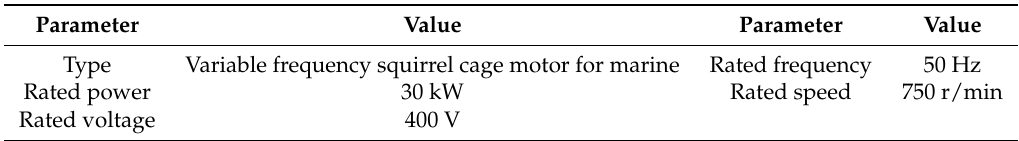
Table 3. Main parameters of the propulsion